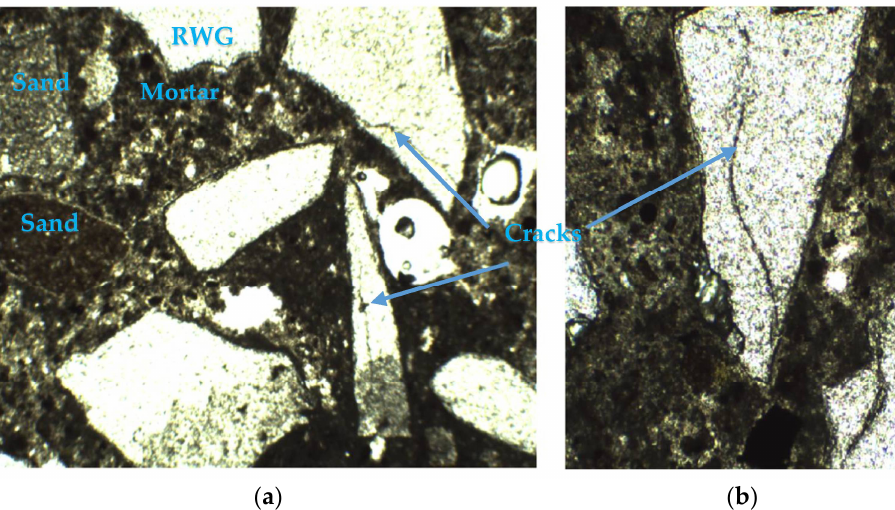
Figure 9. Optical microscopic view of MRGW50 after autoclaving test of durability against ASR: ( a ) at 50 × magnifica- tion; ( b ) at 100 × magnification. ( a ) at 50 × magnification; ( b ) at 100 ×